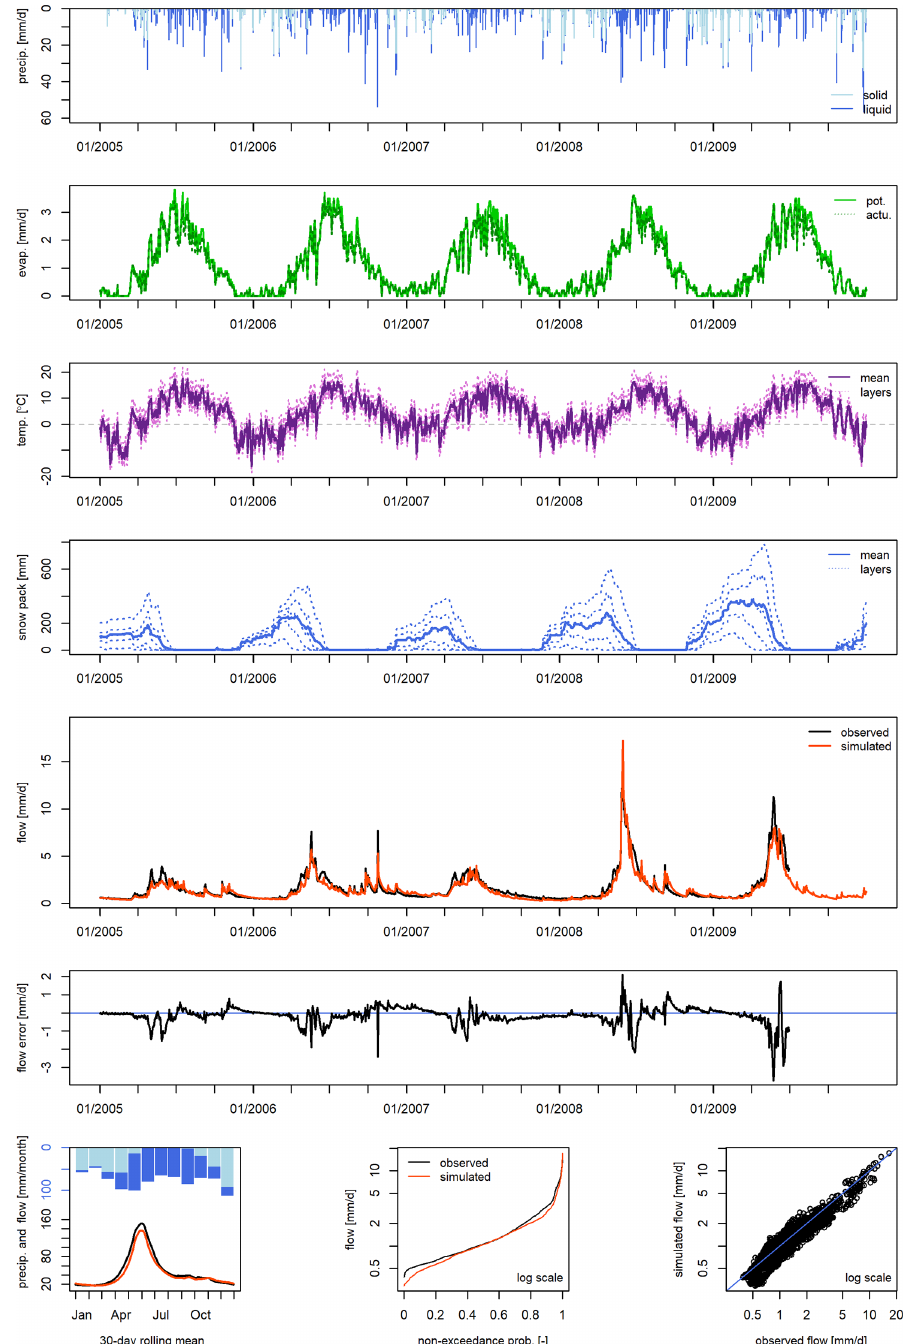
Figure A1. Example of plots enabled by the airGR package. This example was generated by using one of the data sets included in the package and simulations made with the GR4J-CemaNeige hydrological model. From top to bottom: solid and liquid precipitation time series (TS); potential and actual evapotranspiration TS; temperature TS for each layer; snow pack TS for each layer; simulated and observed hydrographs; flow error (or residuals). On the bottom line from left to right: interannual monthly median; cumulative frequency; bias. The hydrographs and the flow error charts can be visualised with a log